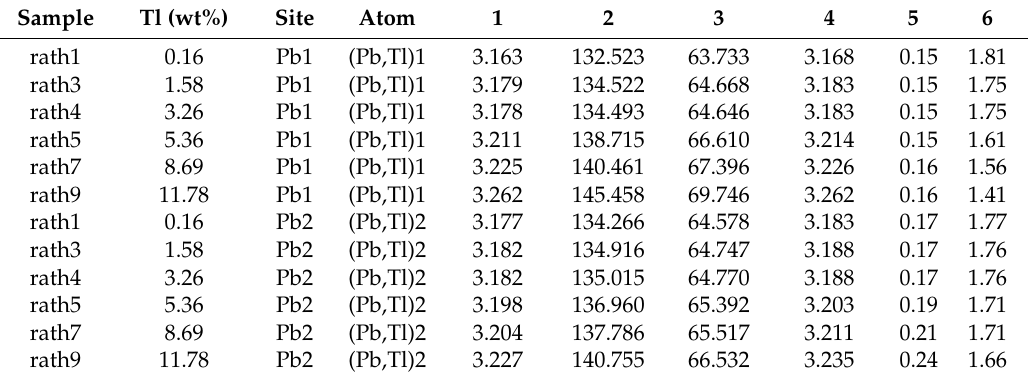
Table 13. Comparison of occcupancies and polyhedron characteristics of the Pb1 and Pb2 sites (CN = 9) in the studied rathite